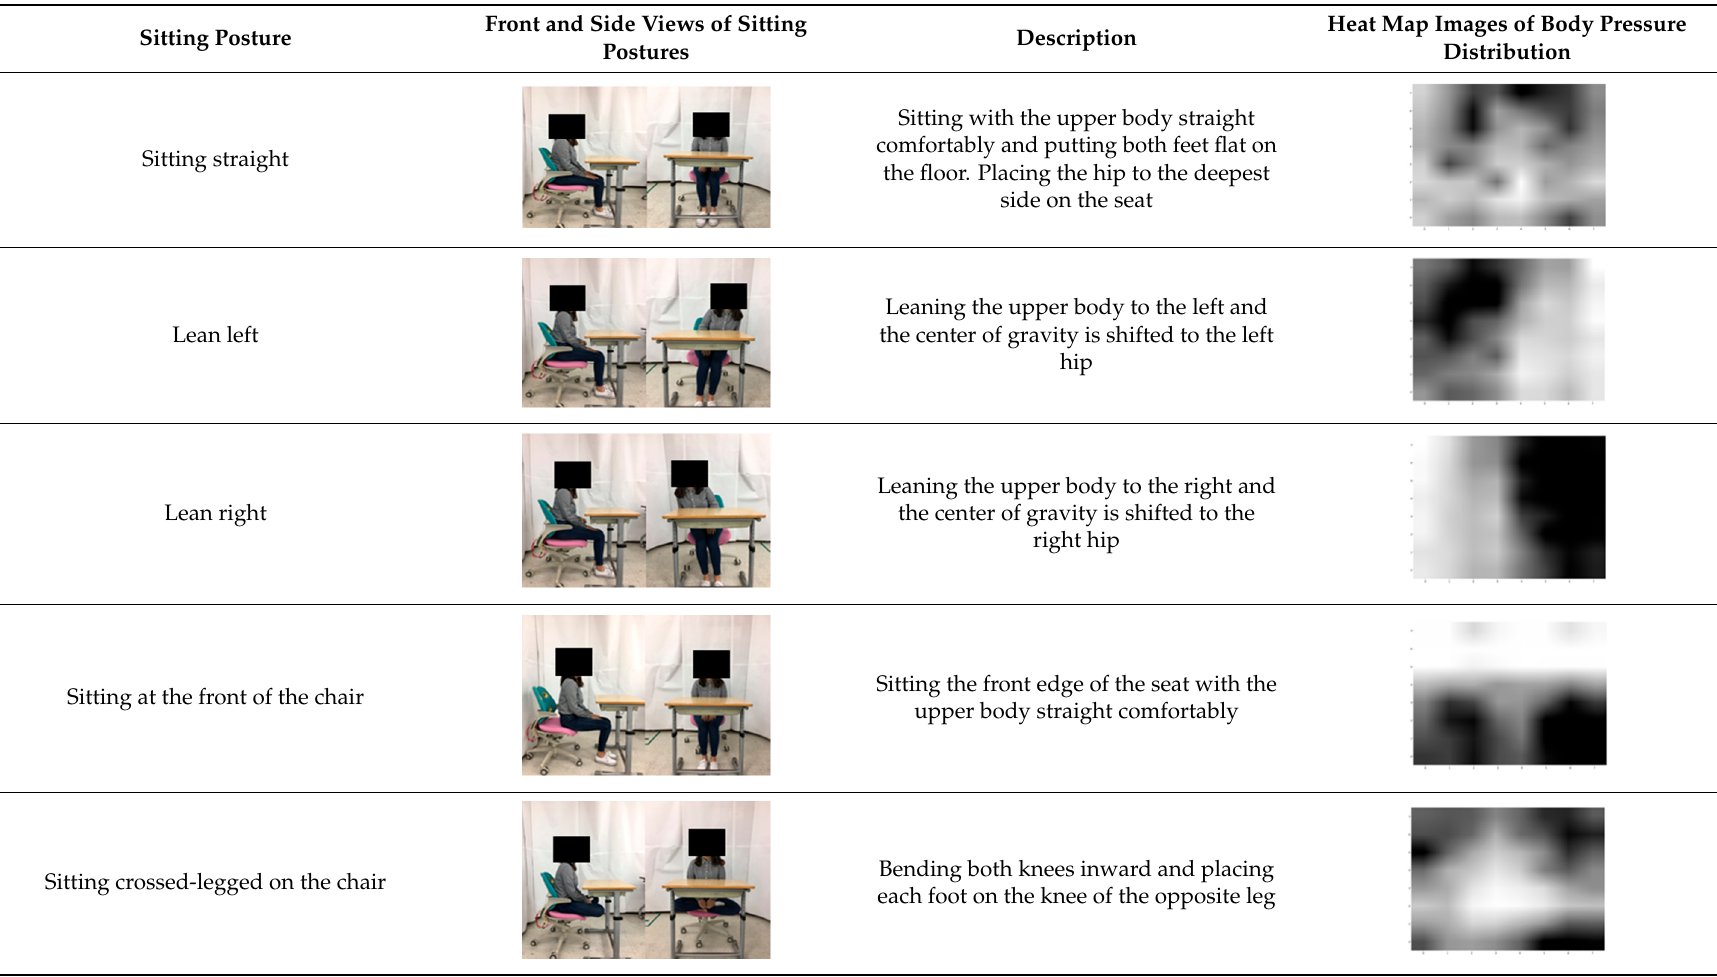
Table 2. Actual and heat map images with description of selected sitting postures.